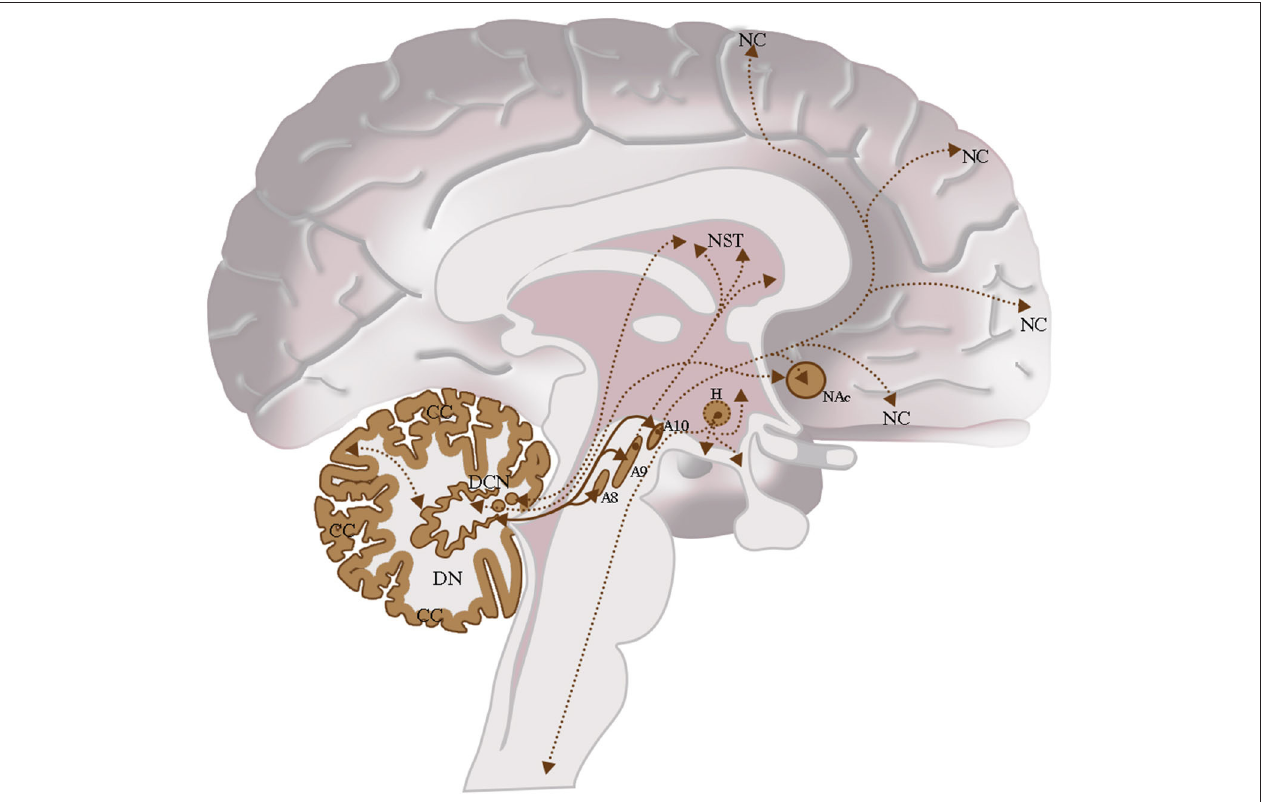
FIGURE 9 | The dopaminergic CNS and their interconnections. Cerebellum: Cerebellar Cortex (CC), Deep Cerebellar Nuclei (DCN); Midbrain: Retrorubral Nucleus (A 8 ), Substantia Nigra Pars Compacta (A 9 ), Ventral Tegmental Area (A 10 ); Hypothalamus (H); Nucleus Accumbens (NAc); Neostriatum (NST); Neocortex (NC). Intrinsic cerebellar dopaminergic interconnections: Between the dentate nucleus (DN) and the cerebellar cortex (CC); these interconnections are indicated in brown with the double arrow and the bold line. Extrinsic cerebellar dopaminergic interconnections : Between the dentate nucleus (DN) and the nuclei of the midbrain A 8 , A 9 , and A 10 ; interconnections are indicated in brown with a double arrow and bold line. Between the dentate nucleus (DN) and the Neostriatum (NST); among others Deep Cerebellar Nuclei (DCN) and the NST or the NAc. These interconnections are indicated in brown with the double arrow and the thin dashed line. Other Dopaminergic Interconnections of the CNS : Interconnection between the Ventral Tegmental Area (A 10 ) and the NAc or between the Ventral Tegmental Area (A 10 ) and the Neocortex (NC). These interconnections are indicated in brown with the double arrow and the thin dashed